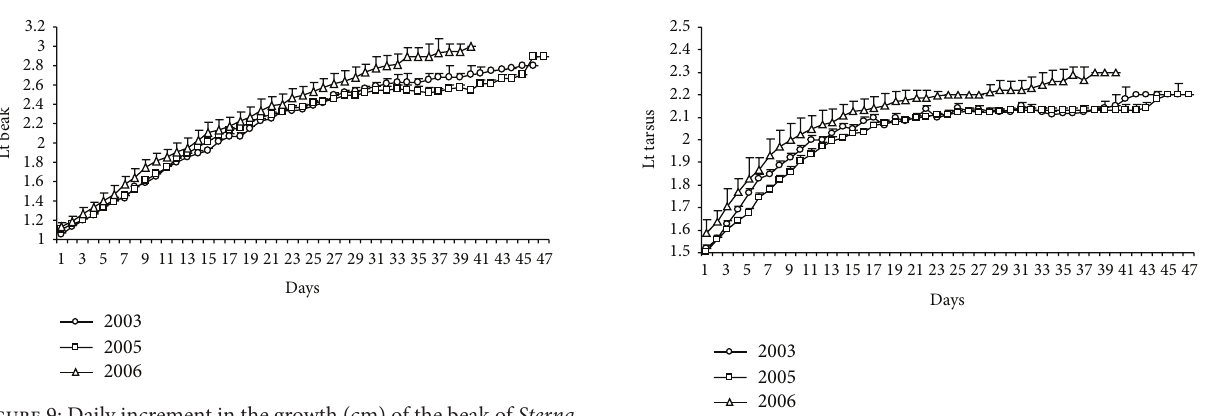
Figure 11: Daily growth of the tarsus (cm) of Sterna hirundinacea chicks.